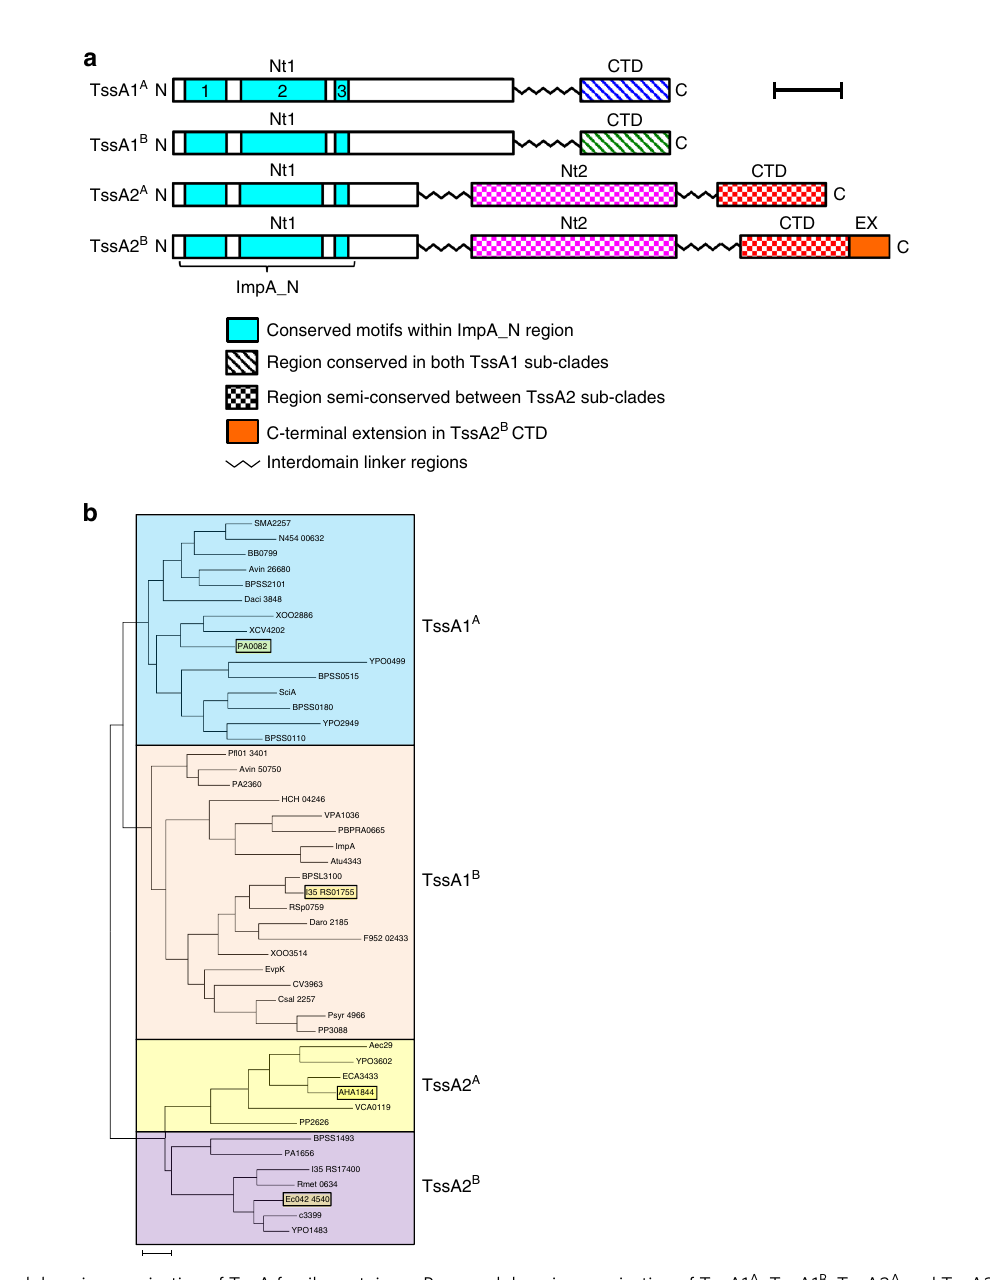
Fig. 1 Phylogeny and domain organisation of TssA family proteins. a Proposed domain organisation of TssA1 A , TssA1 B , TssA2 A and TssA2 B subunits based on structural studies, secondary structure prediction and amino acid sequence alignment. The interdomain linkers comprise regions of variable length and amino acid sequence. The N-terminal conserved region, ImpA_N (comprised of three major regions of conservation, ImpA_N1-3), Nt1, Nt2, CTD and EX (C-terminal extension present in TssA2 B proteins) are indicated. Scale bar corresponds to 50 amino acids. b Maximum-likelihood phylogenetic tree from amino acid sequences of 47 TssA family members, showing the subdivision into three major clades as observed previously 28 but with a revised nomenclature. The TssA2 clade is further divided into sub-clades A and B, based on patterns of sequence identity. TssA members discussed in detail in this study are highlighted in dark yellow. Scale bar represents 0.2 substitutions per